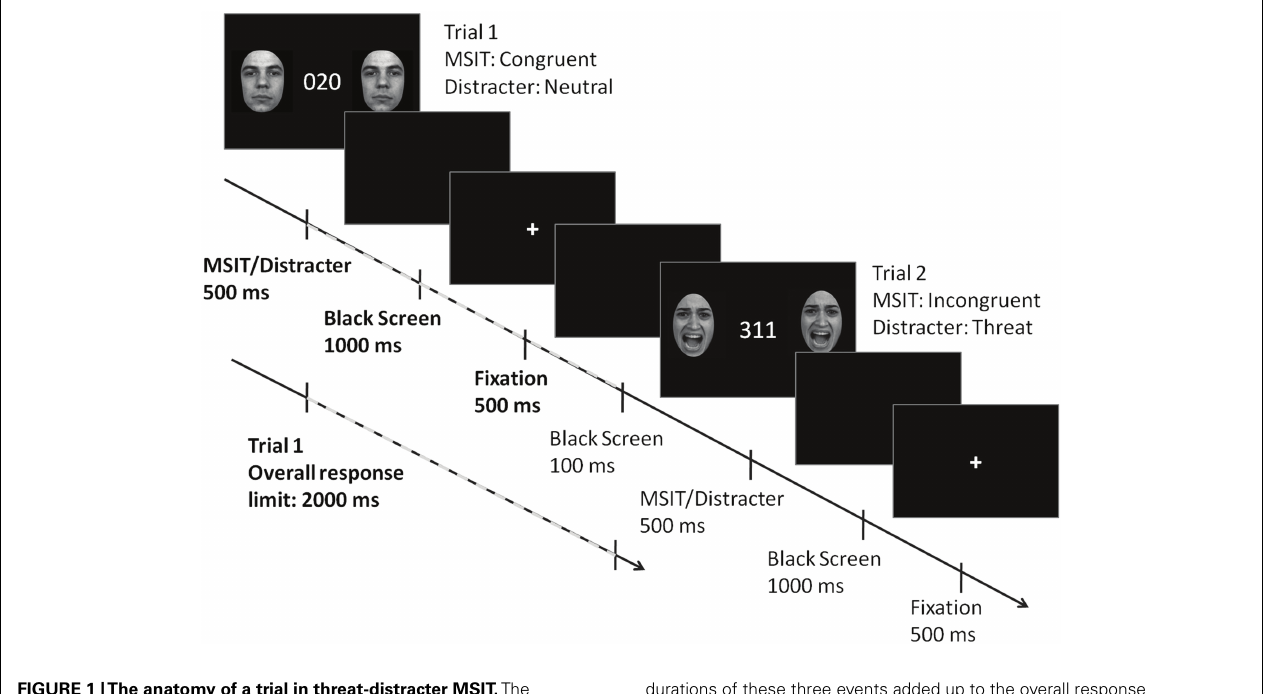
FIGURE 1 |The anatomy of a trial in threat-distracter MSIT. The MSIT stimuli and two identical flanking distracter images were presented simultaneously for 500ms, followed by a black screen for 1000ms, and then a fixation cross for another 500ms.The